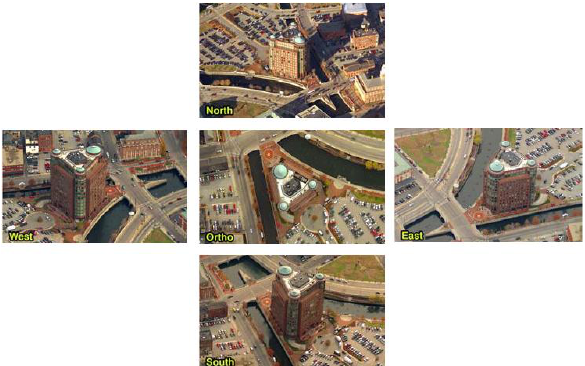
Figure 4. Five views of a building (Nelson,